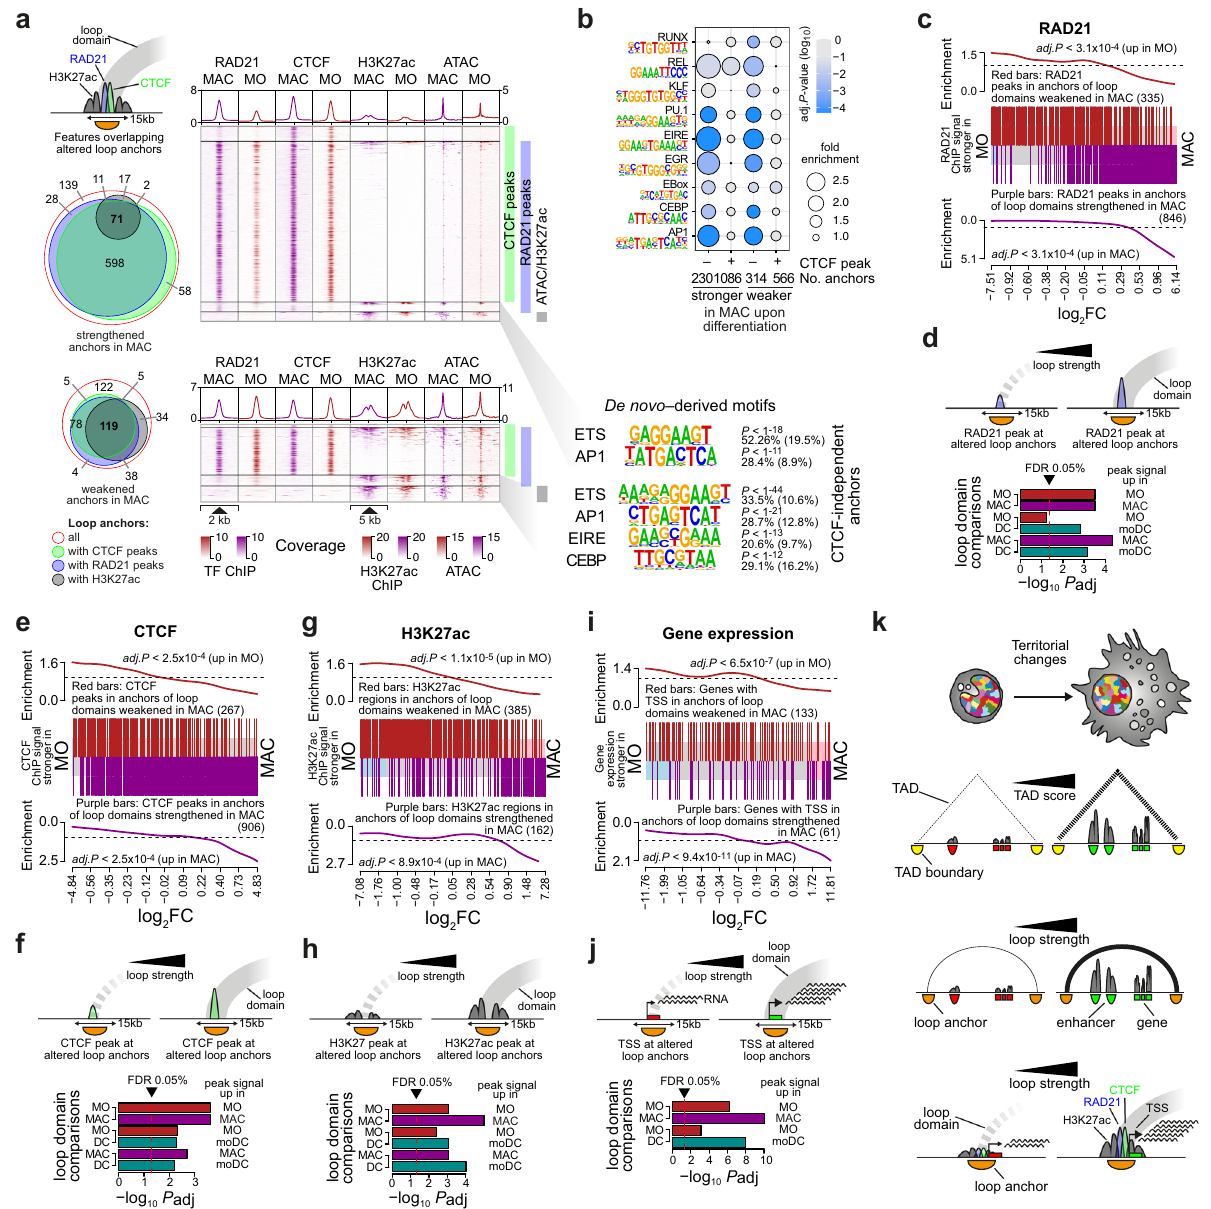
Fig. 4 Differentiation-associated shift from regulatory to structural loops. a Genomic distance distribution of RAD21, CTCF, H3K27ac ChIP-seq, and ATAC-seq coverage at peak-centered loop anchors (divided into four groups, as indicated, and sorted by H3K27ac coverage) that were either strengthened or weakened in MAC compared to MO. Loop anchor size is indicated in the schematic in the top left corner, where the arch indicates the loop domain. Venn diagrams on the left show the overlap between cell type-speci fi c loop anchors, RAD21, CTCF, and H3K27ac peaks for each set. Top de novo - derived motifs for CTCF-independent loop anchors are given on the right along with the signi fi cance of motif enrichment (hypergeometric test) and the fraction of motifs in peaks (background values are in parenthesis). b Balloon plot showing motif enrichment along with color-coded P -values (hypergeometric test, BH adjusted) across open chromatin at CTCF-independent differential loop anchors or CTCF peak areas at CTCF-overlapping differential anchors in MAC compared to MO. c Peak set enrichment of loop anchor-associated RAD21 peaks ( P -values: two-sided rotation tests, BH correction for multiple testing). The enrichment of peaks associated with cell type-speci fi c loops (MO in red, MAC in purple) across all peaks ranked by their signal in MO versus MAC is plotted. d Summary of P -values (two-sided rotation tests, BH correction for paired tests) for pairwise comparisons between MO, MAC and moDC indicating that loop formation correlates with cell-type-speci fi c RAD21 signals. e , f Peak set enrichment of loop anchor- associated CTCF peaks (equivalent to c , d ). g , h Peak set enrichment of loop anchor-associated H3K27ac peaks (equivalent to c , d ). I , j Gene set enrichment of genes with loop anchor-associated TSS (equivalent to c , d ). k Schematic summary of the observed architectural changes during MO differentiation. In general, architectural changes were concordant with changes in gene expression or the activity of regulatory elements, both within domains (loops and TADs), as well as at loop anchors. ( a , b , d , f , h , j ) Source data are provided as a Source Data fi